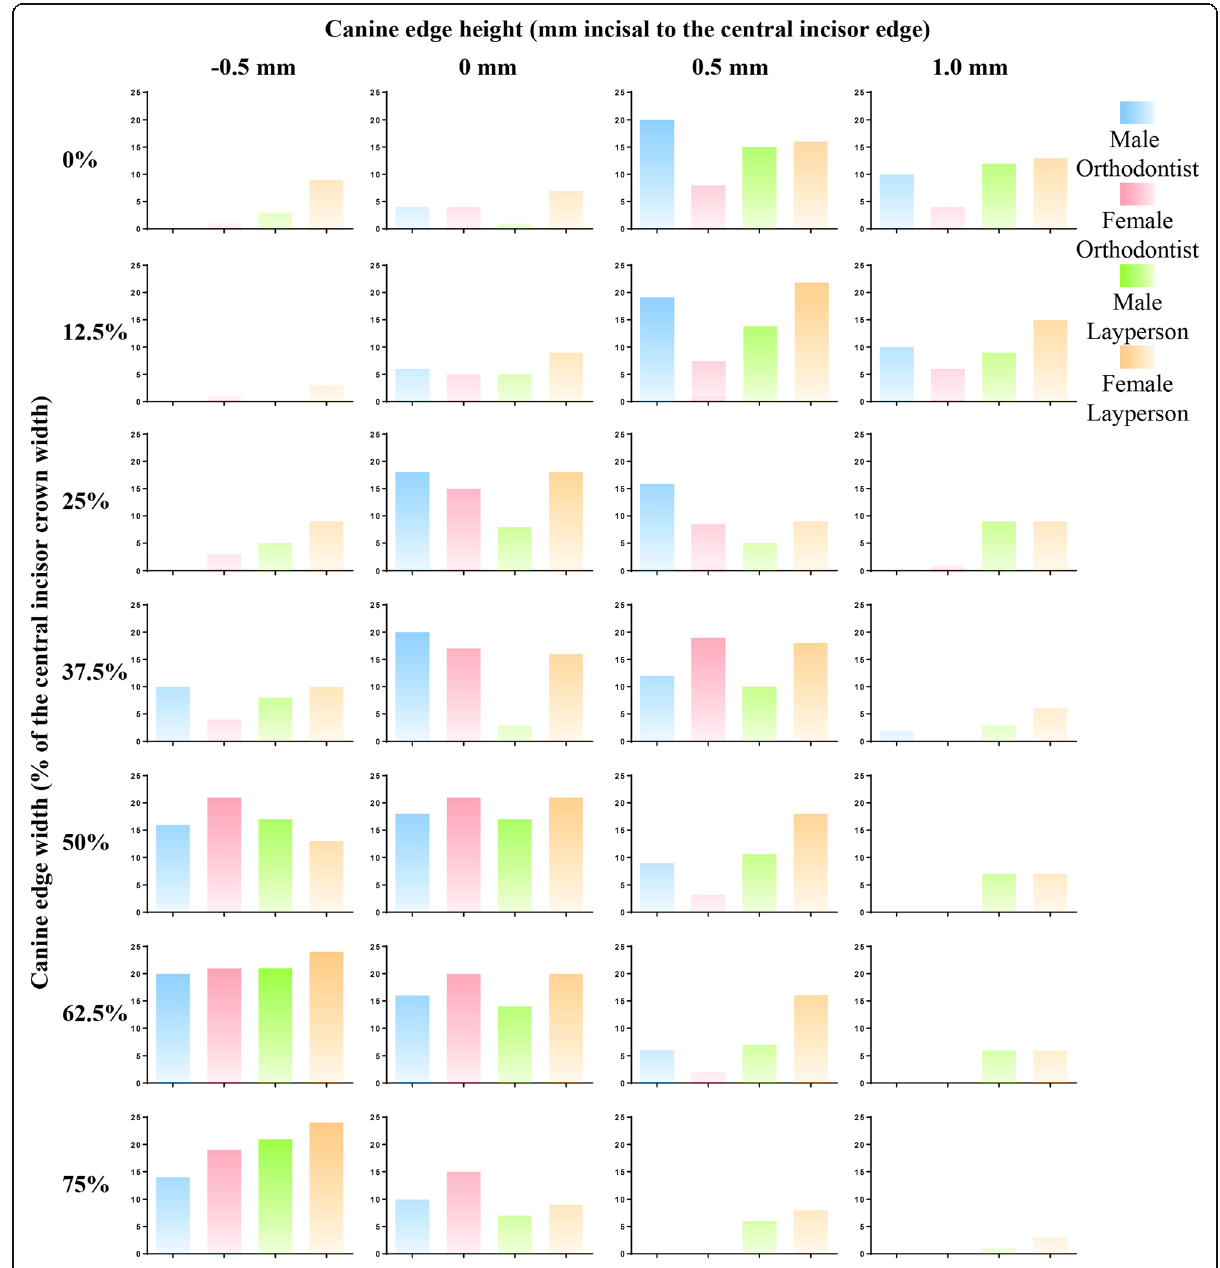
Fig. 3 The frequency of the canine shapes that graded as “ very attractive ” and “ attractive ” by each subgroup (male orthodontist, female orthodontist, male layperson, and female